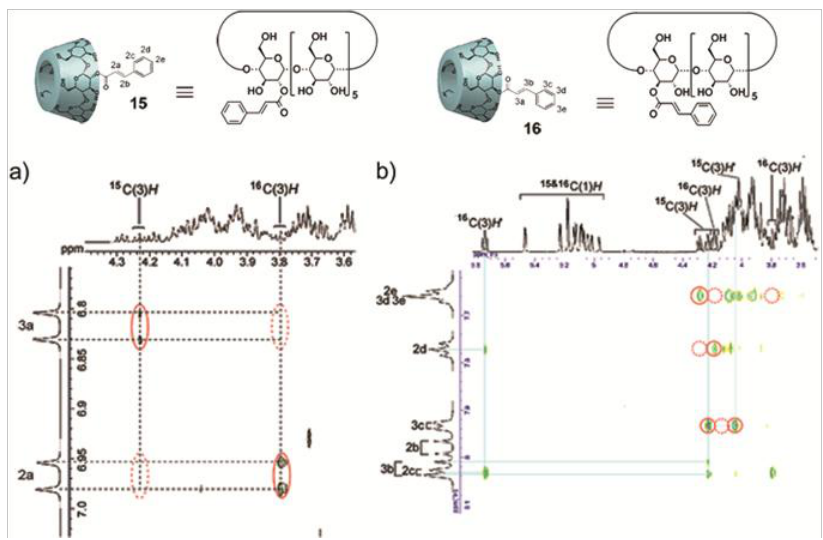
Figure 7. Molecular structures of 2-CiO-α-CD ( 15 ) and 3-CiO-α-CD ( 16 ). Two-dimensional ROESY NMR spectra ( a , b ) of the mixture of 15 and 16 in D (32 mM) at 20 °C. The spectrum shows the partial area between inner protons of CiO-α-CDs and olefin protons of the cinnamoyl group. The correlation peaks were observed in the area of solid circles, whereas in the dash circles were not observed. ( c ) Illustration of the formation of supramolecular complexes using CiO-α-CDs. Reprinted with permission from [37]. Copyright 2009 American Chemical